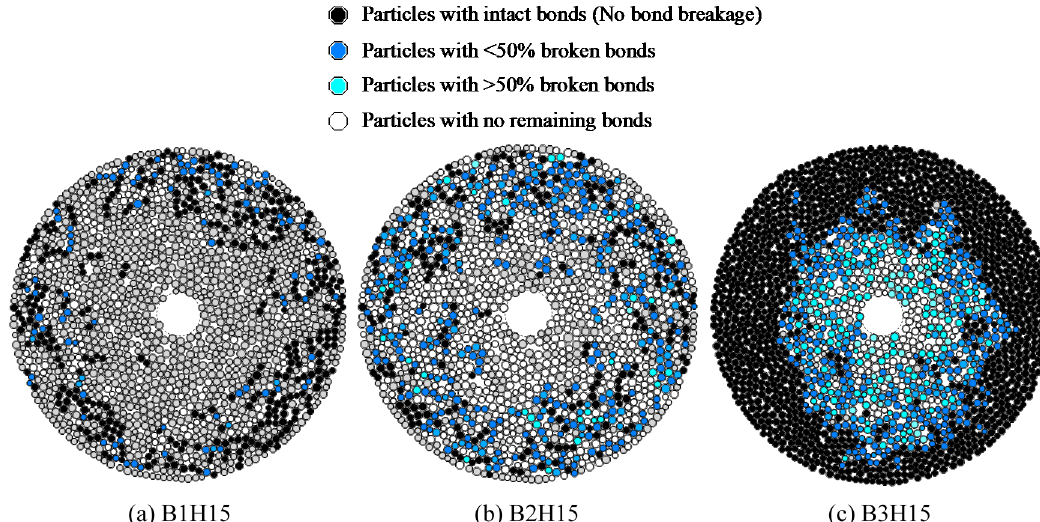
Figure 17. Distribution of broken bonds before the occurrence of catastrophic sand production in: ( a ) B1H15 model; ( b ) B2H15 model; and ( c ) B3H15 model. Black particles represent particles with intact bonds (without any breakages). Dark blue particles denote particles with few broken bonds (less than half of the initial bonds), and light blue particles represent particles with a large number of broken bonds (more than half of initial bonds). White particles are purely frictional with no remaining bonds.